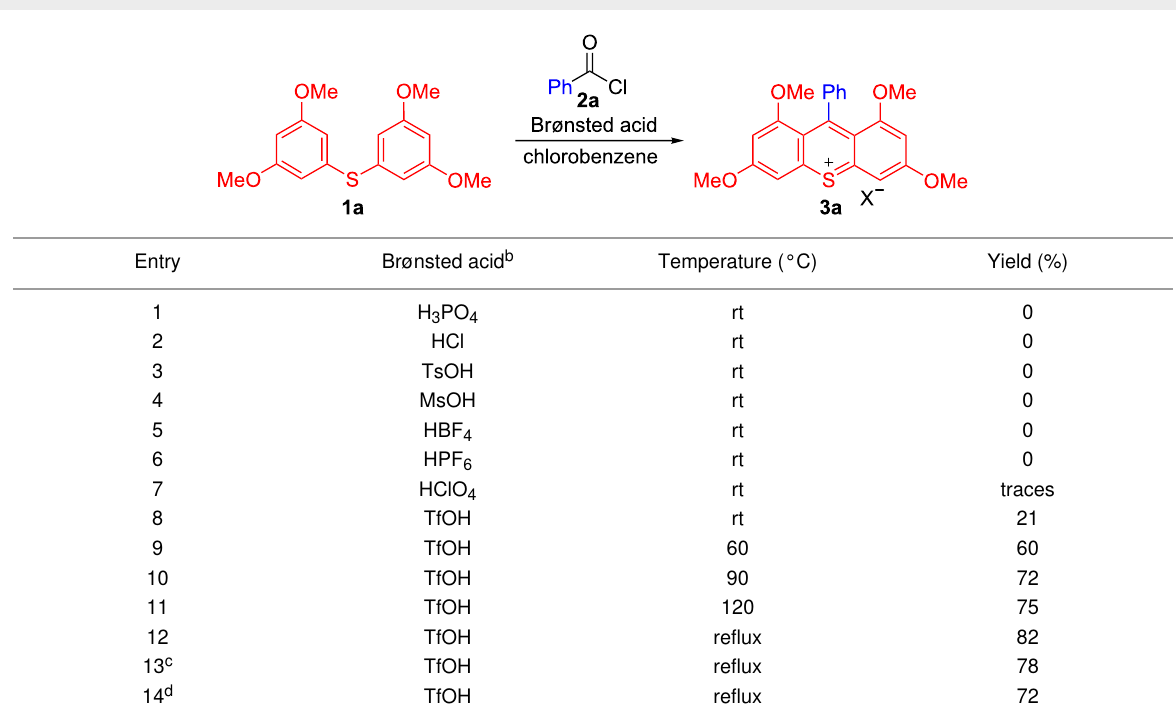
Table 1: Optimization of the reaction conditions a